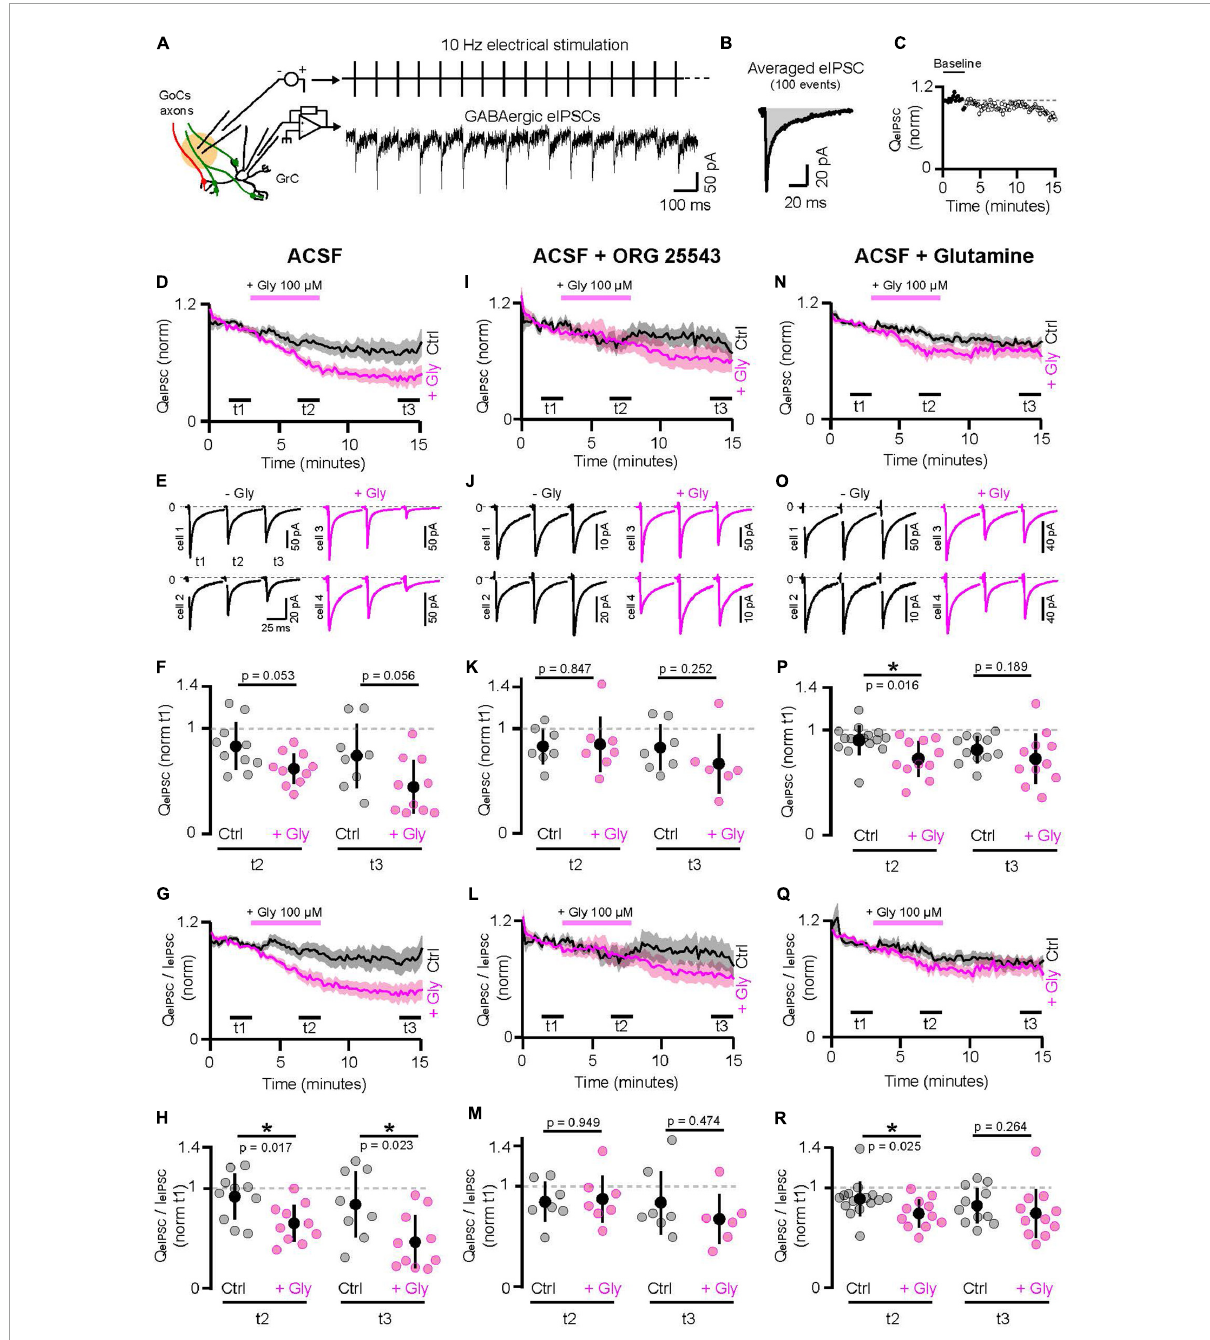
FIGURE1 Manipulation of GABA and glycine supply to GoCs affect GrCs inhibition. (A) Left, schematic of the experiment. GABAergic IPSCs recorded from GrCs in whole cell configuration are evoked by the continue electrical stimulation (eIPSC) at 10 Hz of GlyT2( − ) and GlyT2(+) GoCs axons without any distinction. Right, a GrC recording during 10 Hz stimulation of the GoCs axons. GABAergic eIPSCs have been pharmacologically isolated with the following cocktail of blockers: APV 50 µ M, NBQX 2 µ M, strychnine 0.5 µ M, CGP55845 1 µ M, and ORG24598 1 µ M. (B) Average of 100 consecutive GrC eIPSCs following the electrical stimulation. The strength of the GABAergic transmission over the time is estimated by taking the charge (QeIPSC, gray area) of the averaged eIPSCs every 10 s. (C) Example of the QeIPSC over the time. Each dot was normalized by the mean signal in the baseline (3 min from the beginning, full dots). (D) Populational evolution of the GABAergic transmission over the time in ACSF (ctrl, black, n = 8–10) or ASCF + glycine 100 µ M for 5 min (+Gly, pink, n = 10). Traces represent the mean normalized charge ± SEM. (E) Average of 1000 eIPSCs at t1, t2, and t3 in ctrl (black) and with glycine application (pink) . Two representative pairs are shown for each condition. (F) Charge measured from 1000 consecutive eIPSCs averaged at the end of the glycine application (t2) and at the end of the recordings (washout, t3), normalized by the baseline (t1). (G,H) Same as panels (D,F) using the charge to peak ratio (QeIPSC/IeIPSC) . (I–M) Same as panels (D–H) in presence of ORG25543 1 µ M, the specific blocker of GlyT2 (ctrl n = 7, +Gly n = 6–7). (N–R) Same as panels (D–M) in ACSF supplemented with 500 µ M of Glutamine (Gln), the precursor of the GABA synthesis (ctrl n = 11–15, +Gly n = 11). * p < 0 .